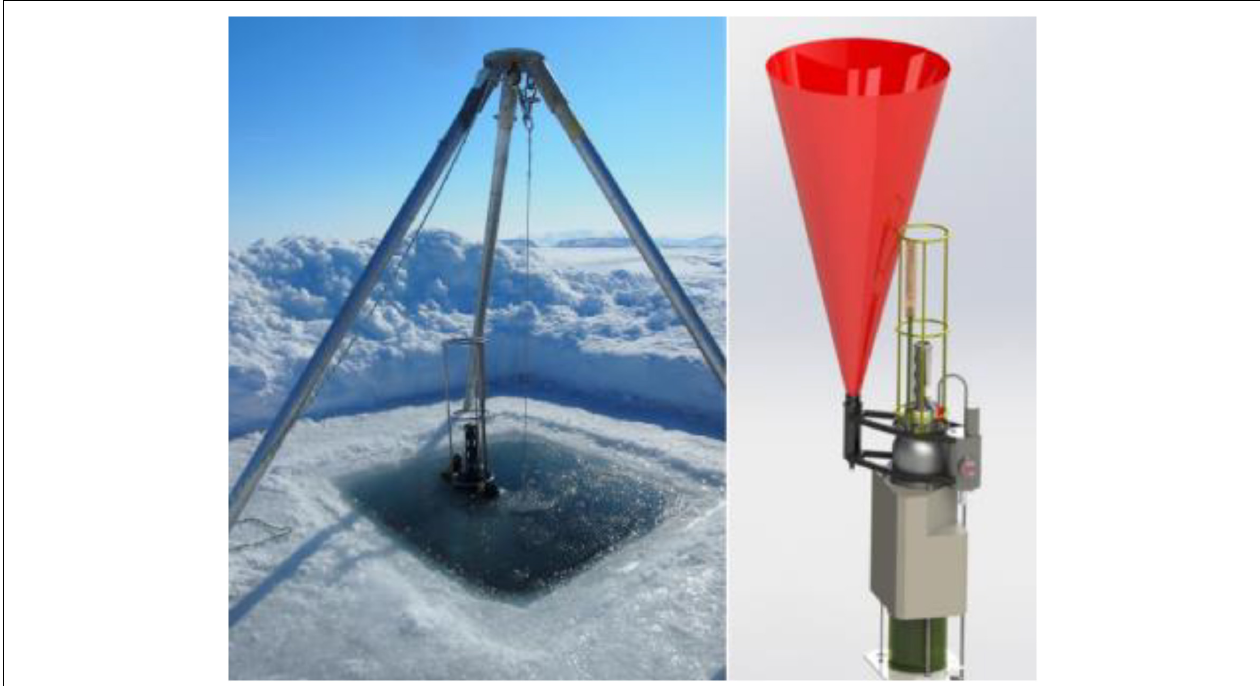
FIGURE 5 | Left : Field trial at the Green Edge ice camp (courtesy of C. Marec ). Right : Pro-Ice float design with antenna cage and upward-looking altimeter (PSA-916, acoustic beam in red).